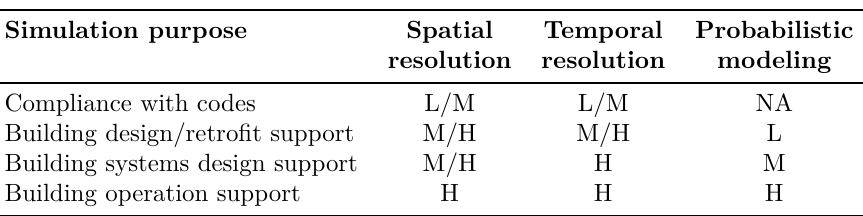
Table 2. Fitting spatial and temporal resolution levels of occupant models as well as their suitability for inclusion of probabilistic features as a function of the simulation application use case (L: low; M: medium; H: high).